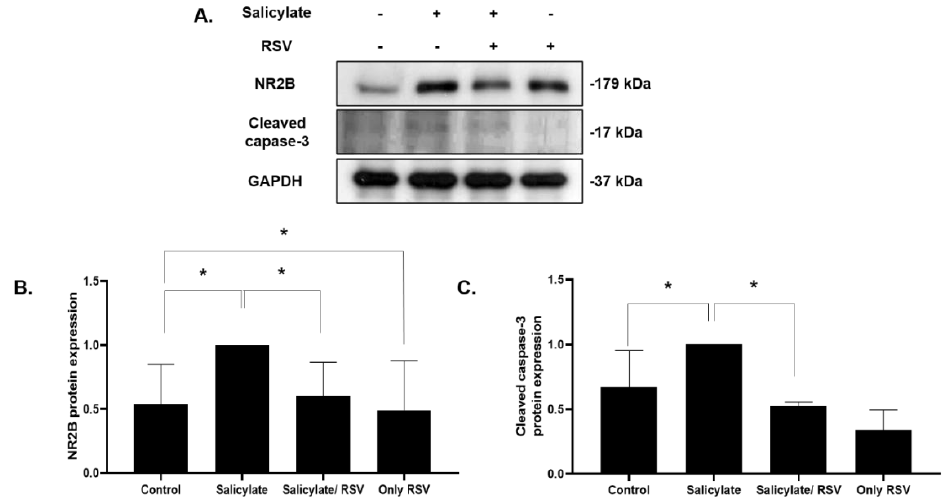
Figure 4. Effect of resveratrol (RSV) on the expression of NR2B and cleaved caspase-3 in rat cortical neuronal cells. Immunoblot analysis of the expression of NR2B and cleaved caspase-3 ( A ). Expression of NR2B ( B ) and cleaved caspase-3 ( C ) quantified using ImageJ (* p < 0.05, mean ± SD). GAPDH was used as the internal standard. NR2B: NMDA receptor subunit